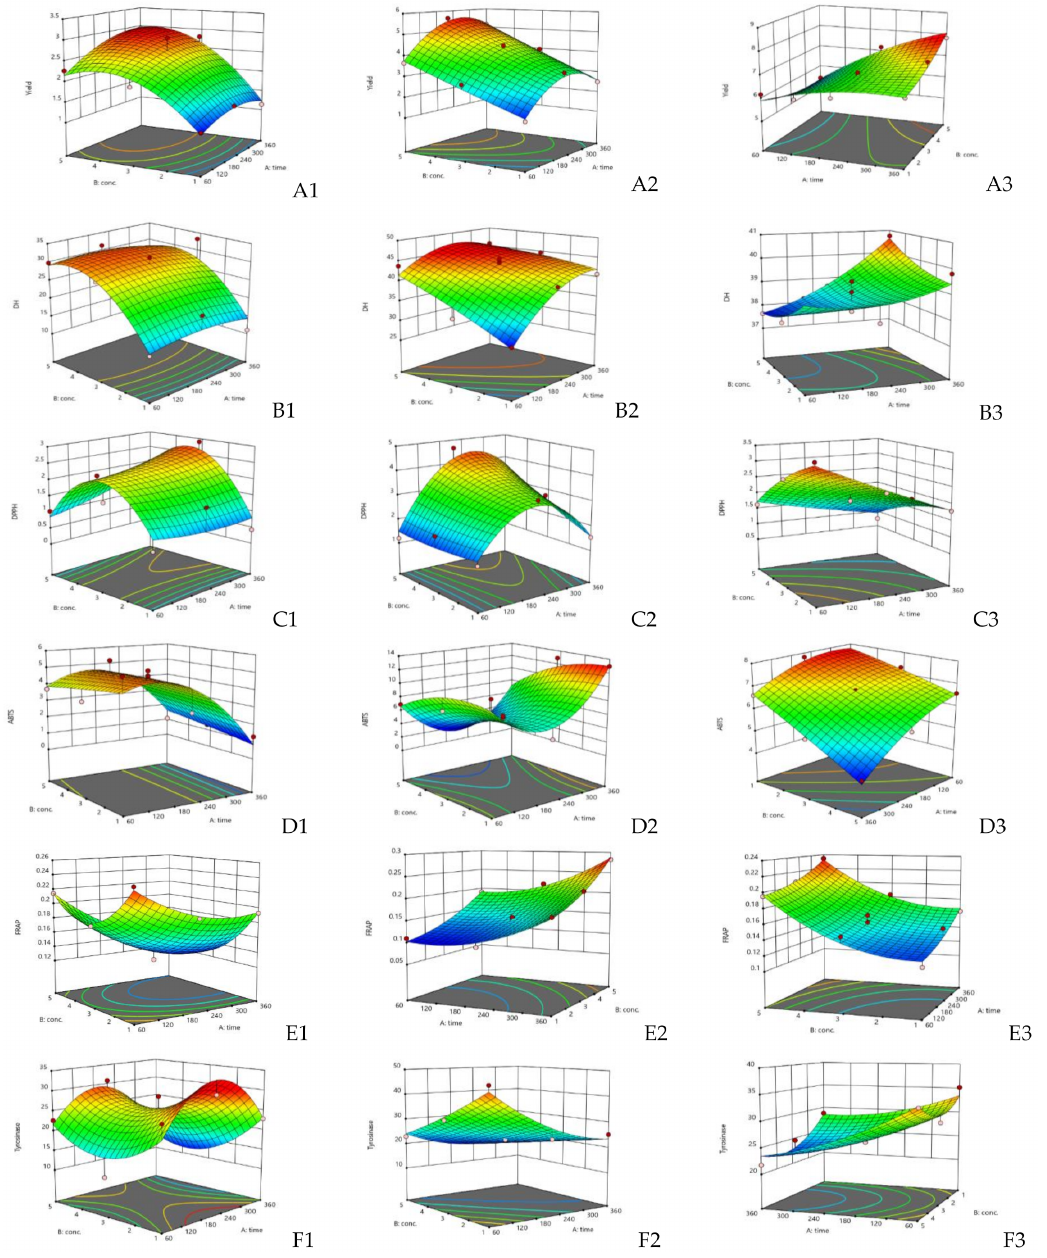
Figure 1. Response surface plots for DH, yield, IC 50 of DPPH and ABTS radical scavenging, and tyrosinase inhibitory activity: and FRAP value using alcalase ( A1 – F1 ), flavourzyme ( A2 – F2 ), and papain ( A3 – F3 )